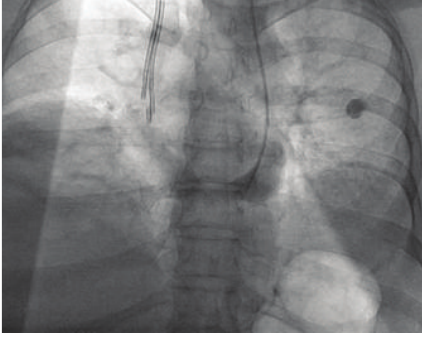
Figure 1: Persistence of left superior vena cava during X-ray fluoroscopic placement of tunnel dialysis catheter.